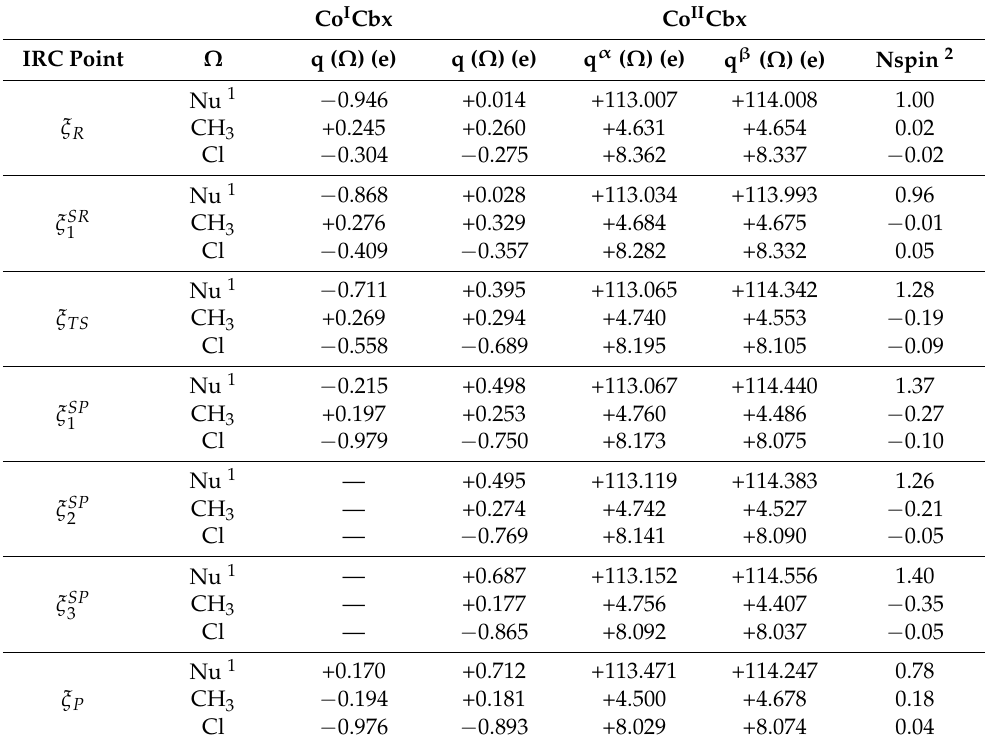
Table 3. Bader charges, for reactions mediated by Co I Cbx and Co II Cbx in the indicated IRC points. For reaction mediated by Co II Cbx explicit spin α and β charges and spin population are